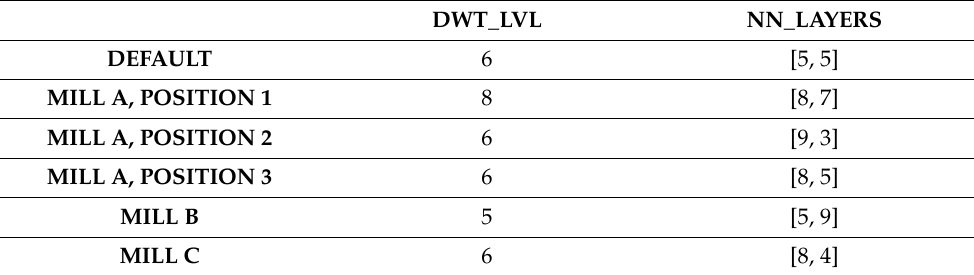
Table 6. Hyperparameter values after optimization.